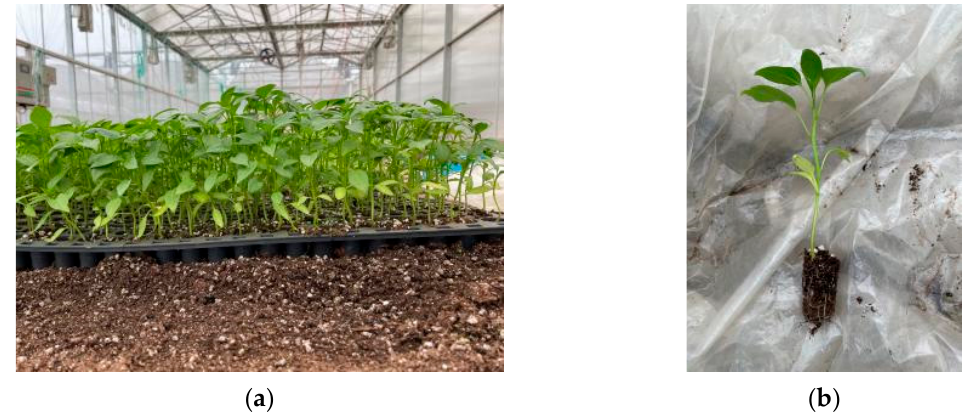
Figure 6. Pepper pot seedlings for material tests. ( a ) Whole pot seedlings. ( b ) Single pot seedling. Twenty randomly selected potted seedlings were tested for material